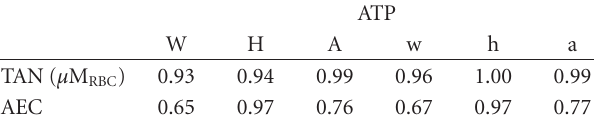
Table 3: Correlation coe ffi cient ( r ) between ATP concentration and total adenylate nucleotide pool (TAN) and values of the adenylate energy charge (AEC) in erythrocytes of stallions and mares Wielkopolska breed (W,w), Hanoverian breed (H,h), Ardenian breed (A, a); ∗ -significant di ff erence ( P < .05).